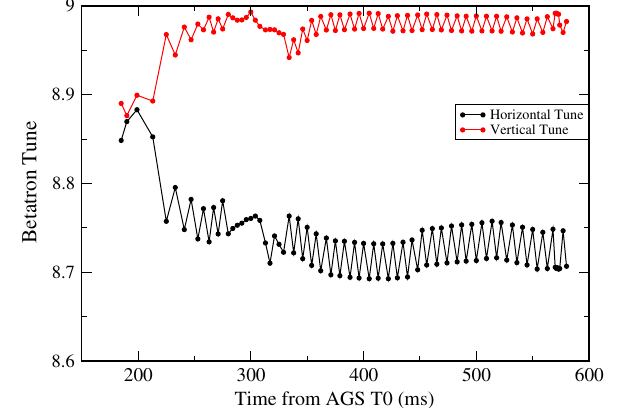
FIG. 8. Sketch of a resonance crossing on the increase ν x side of the pulse ( G γ ¼ 54 − ν x ¼ 45 . 3 ). The horizontal axis is relative time to the resonance crossing. The vertical axis is energy relative to the synchronous particle at jump time in unit of G γ . The solid line applies to the synchronous particle, and the two types of broken lines apply to the boundary particles at the (cid:1) FWHM. The resonance lines (red) are given by Eq. (4) for positive and negative momentum spreads. The momentum FWHM width is assumed as 10 − 3 , which is close to the real dp=p at late part of the ramp. The chromaticity of -8 is used for the plot. The ramp rate dG γ =dt is 0 . 117 = ms. The plot shows that particles within FWHM (76% beam) benefit from the tune jump in this case.